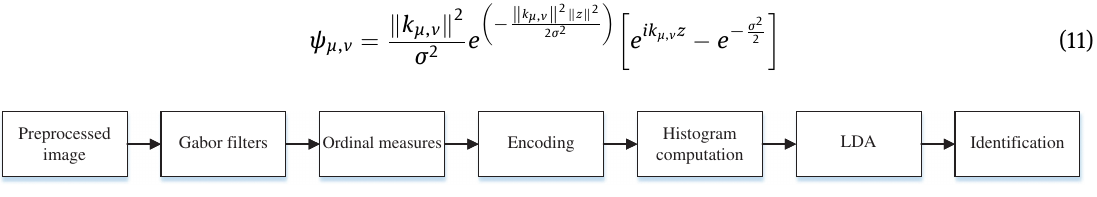
Figure 7: GOM Face Recognition